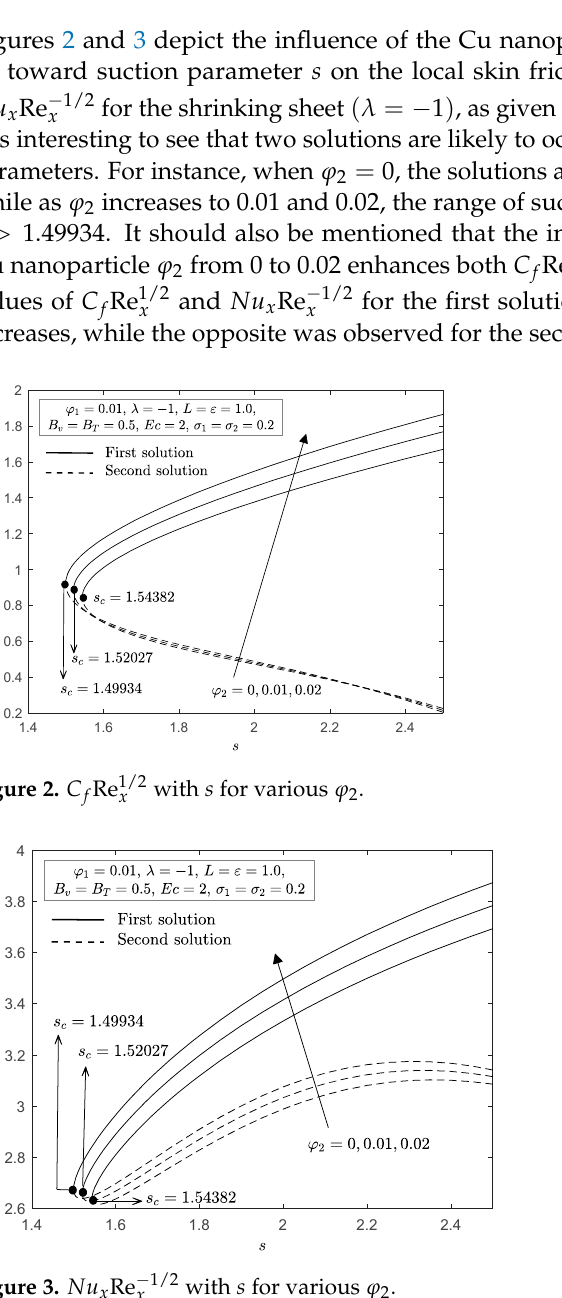
ϕ Figure 3. Nu 2